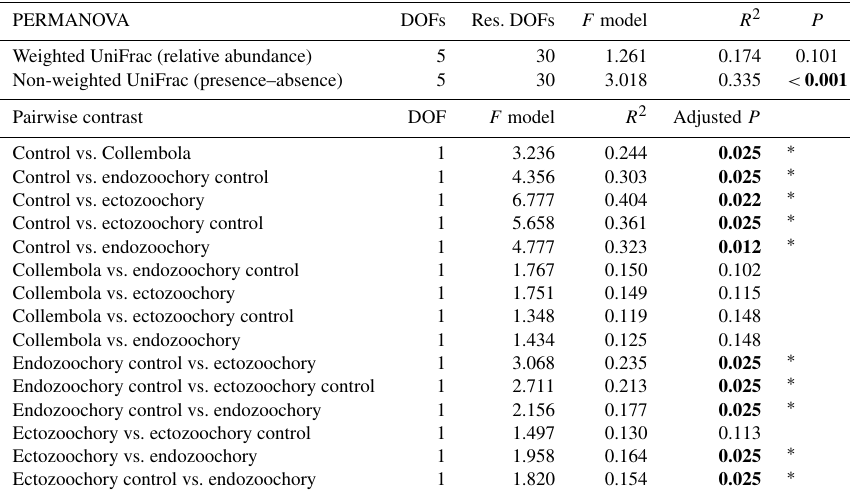
Table C1. Effects of Collembola additions on bacterial community composition (permutational multivariate ANOVAs and pairwise con- trasts), using distance matrixes based on relative abundances (weighted UniFrac) or presence–absence (non-weighted UniFrac). Holm ad- justment for P values of pairwise contrasts. P values below 0.05 are denoted in bold; ∗∗∗ P < 0.001; ∗∗ 0.001 <P < 0.01; ∗ 0.01 <P < 0.05; dot ( · ) denotes 0.05 <P < 0.1.